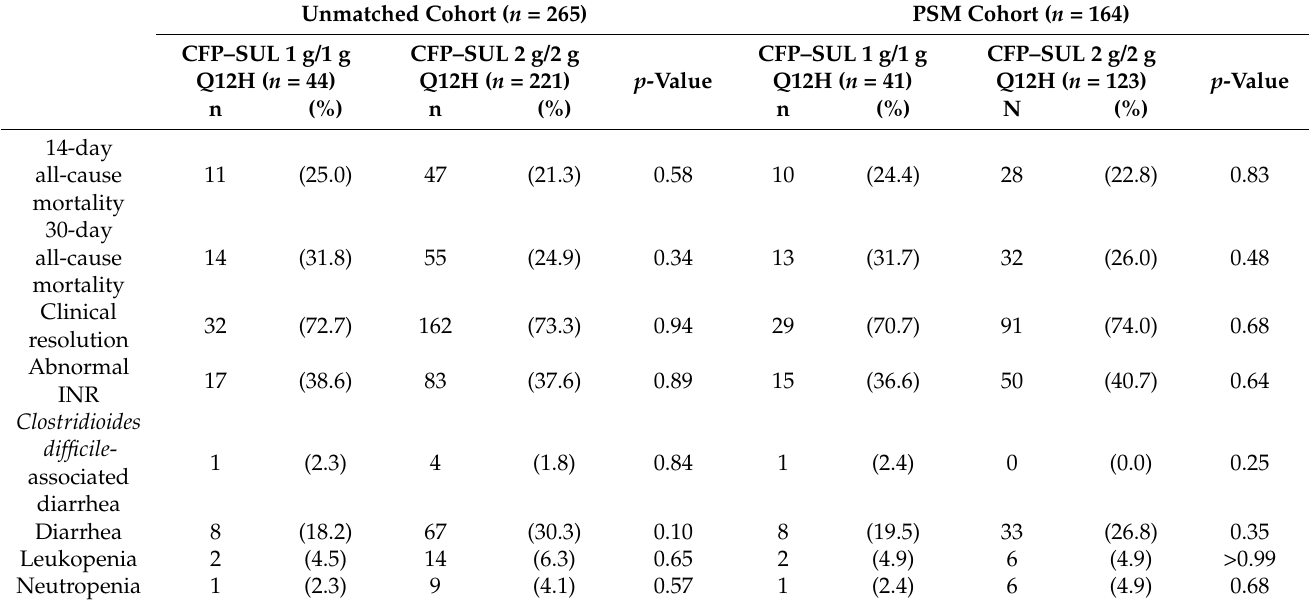
Table 2. Clinical outcomes and adverse effects of unmatched and matched CGRD cohort.